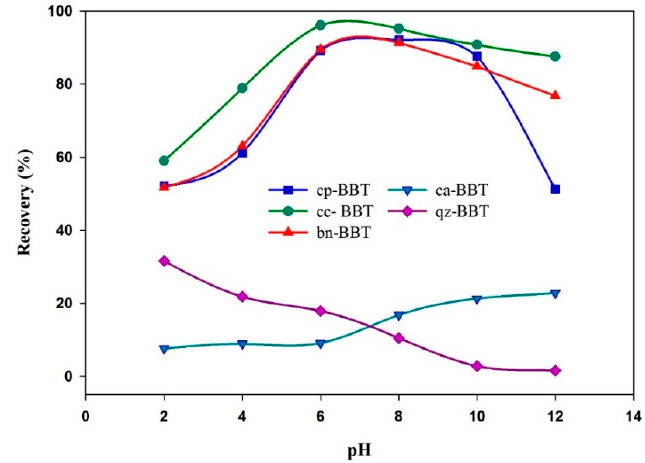
Figure 4. Hallimond flotation recovery as a function of pH at collector concentration 4 × 10 − 5 M. cp-chalcopyrite, cc-chalcocite, bn-bornite, ca-calcite, qz-quartz.